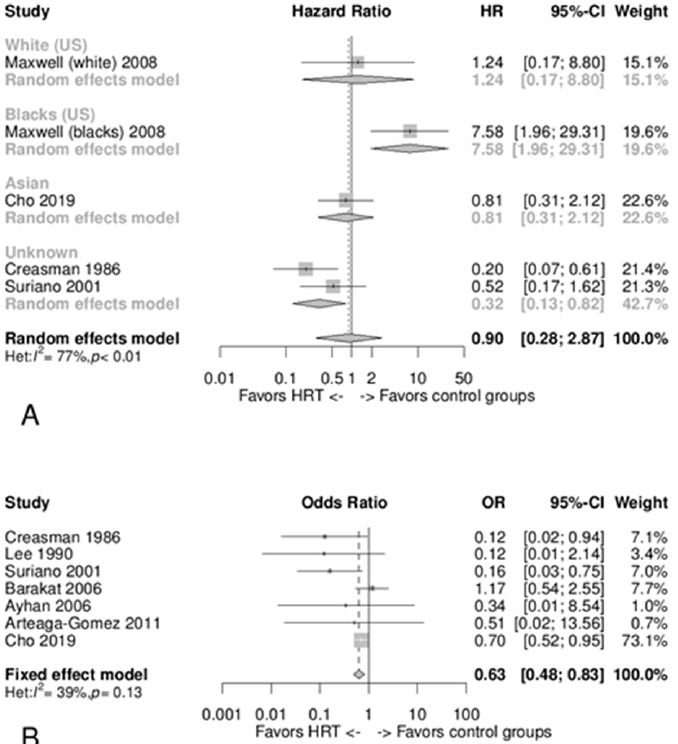
Figure 2. Panel ( A ) Forest plot of hazard ratio (HR) meta-analysis for disease-free survival/recurrence risk showing a pooled random effect model and subgroup analysis by ethnicity (in this analysis, Lim and coworkers were excluded due to a potential overlap with Cho and coworkers). Panel ( B ) Forest plot of odds ratio (OR) meta-analysis for recurrence risk showing a pooled fixed-effect model (in this analysis, Lim and coworkers were excluded due to a potential overlap with Cho and coworkers; and Chapman and coworkers were excluded due to an overlap with Suriano and coworkers).